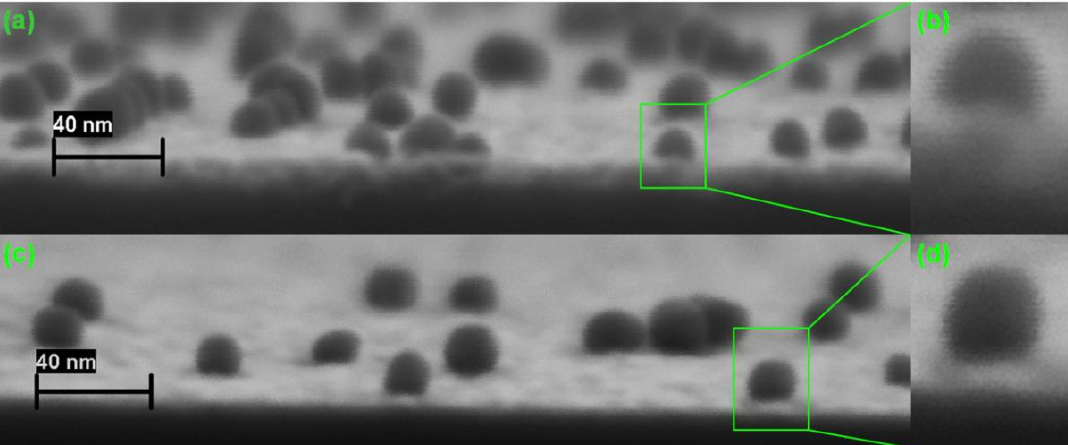
Figure 5. Cross-sectional SEM images of the microchip spots obtained at 80° angle after hybridiza- tion of target oligonucleotide or DNA and development of the duplexes with a streptavidin – GNP conjugate: ( a ) 80 pM target Probe C, ( b ) an enlarged image of one GNP of the duplex with short oligonucleotide, ( c ) 50 pM target DNA containing blaCTX-M-3, ( d ) an enlarged image of one GNP of the duplex with blaCTX-M-3.